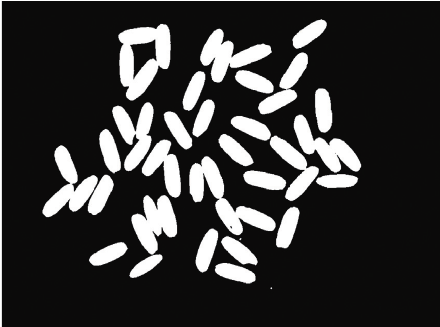
Figure 3: Binary image of brown rice.